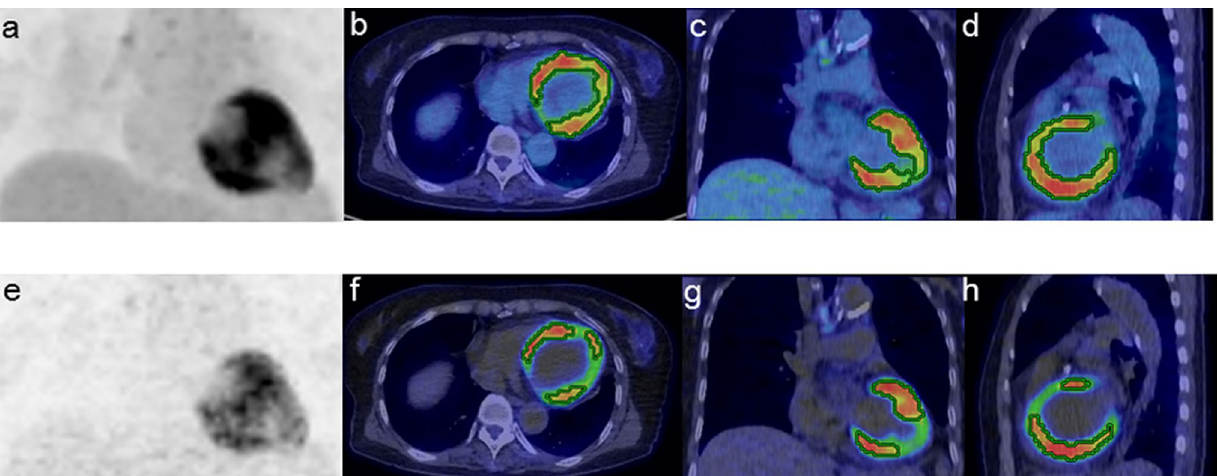
Figure 1. A 70-year-old female patient with CS who showed VT and cardiac dysfunction (EF: 40.0%) before treatment. The SUV images [maximum intensity projection (MIP) ( a ), transaxial ( b ), coronal ( c ), and sagittal ( d )] and Ki images [MIP ( e ), transaxial ( f ), coronal ( g ), and sagittal ( h )] both show the positive myocardium for which the VOIs were automatically determined. The SUV (SUVmax: 8.51 g/ml, SUVmean:4.66 g/ml, CMV: 220.0 cm 3 , CMA: 1025.2 g) and Ki parameters (Ki max: 370.2 × 10 –3 ml/g/min, Ki mean: 214.9 × 10 –3 ml/g/min, Ki volume: 115.3 cm 3 ) were all positive for the risk of arrhythmic events according to each threshold